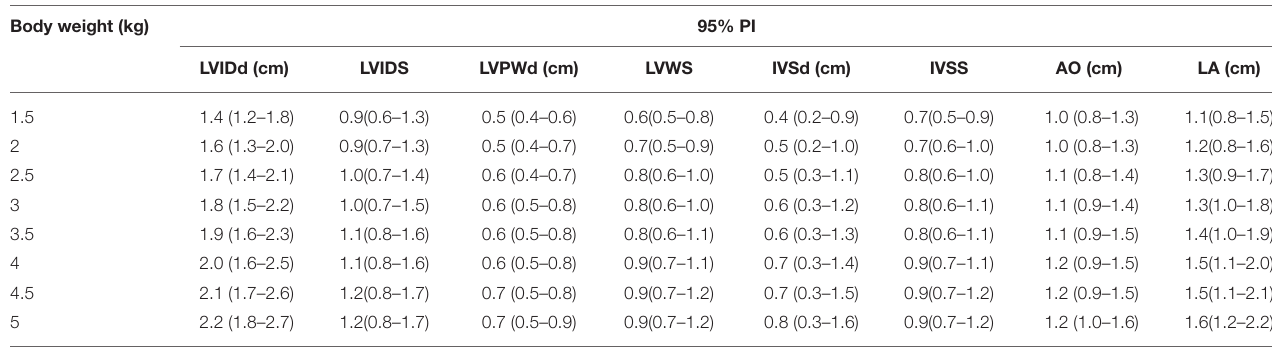
TABLE 3 | Mean value and 95% prediction intervals of the toy breed dogs ( n = 86). Body weight